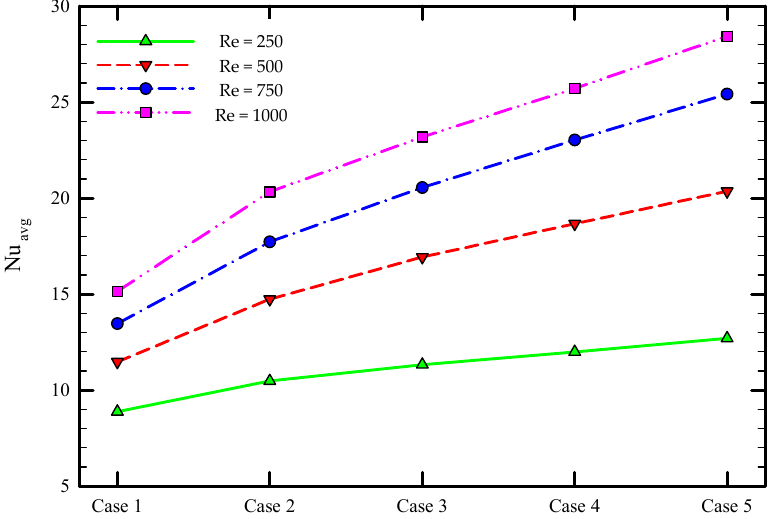
Figure 12. Average Nusselt number for the captured cases at different Re numbers for φ = 0%.